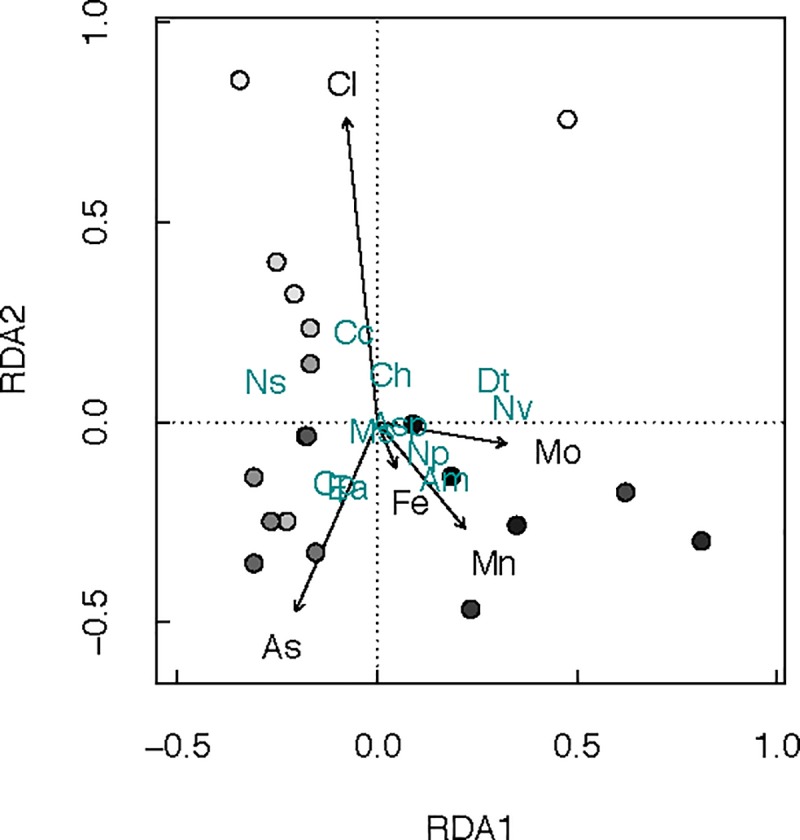
Redundancy analysis.Plot of redundancy analysis (RDA) ordination (axes 1 and 2) for 19 samples with diatom data. The arrows represent the significant environmental variables explaining variation in the diatom assemblages. Species names are in cyan colour and symbolized by initials (Cc: Campylodiscus clypeus; Ns: Nitzschia semirobusta; Ea: Epithemia argus; Cp: Cocconeis placentula; Nv: Navicula veneta; Np: Navicymbula cf. Pusilla; Ch: Craticula halophila; Ms: Mastogloia smithii; Am: Achnanthidium cf. Minutissimum; Asp: Achnanthes sp.; Dt: Denticula cf. thermalis). The points represent depth of samples in the core: white points are top core samples and bottom core samples in black.